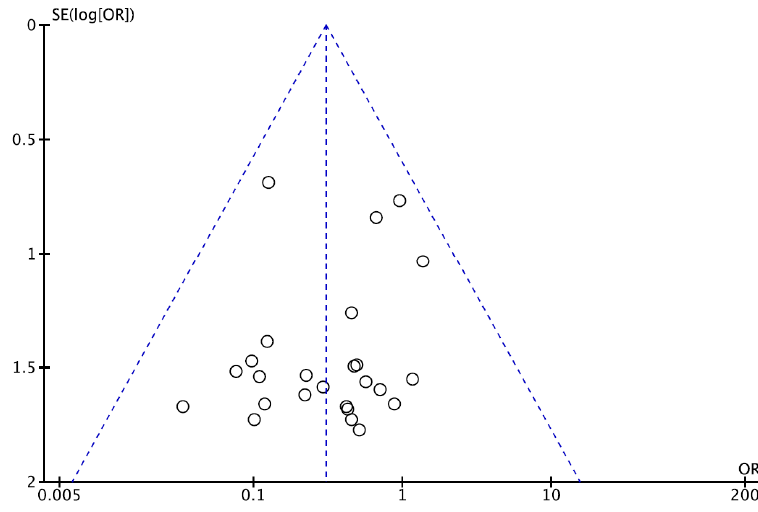
Figure 3. The funnel plot for all the studies included in the present meta-analysis. This is a graphical representation of the size of the papers included, plotted against the effect size they report. Each dot represents a single study; on the y-axis SE (standard error) represents study precision while the x-axis shows the study’s result in terms of odds ratio.